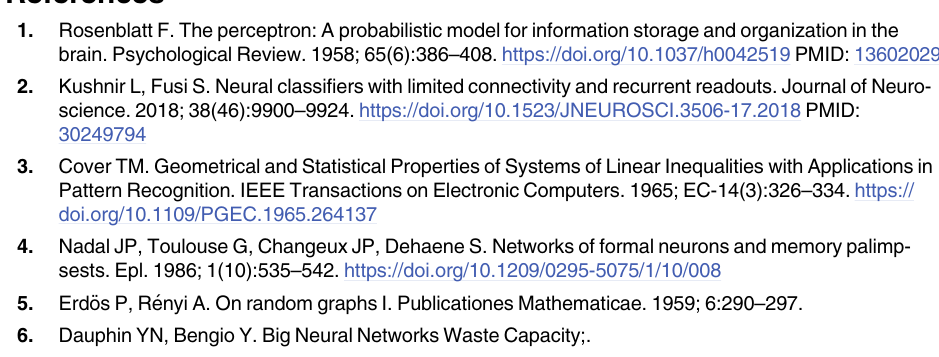
S2 Fig. OS+ failure. The OS+ Hebbian training method fails to maintain previously stored patterns when pushed beyond maximum capacity. We report sparse RNN performance as a function of the training epoch when trained with the OS+ method. Thick lines are averages and thin lines are individual simulations. f = 0.1, α = 0.007, n =